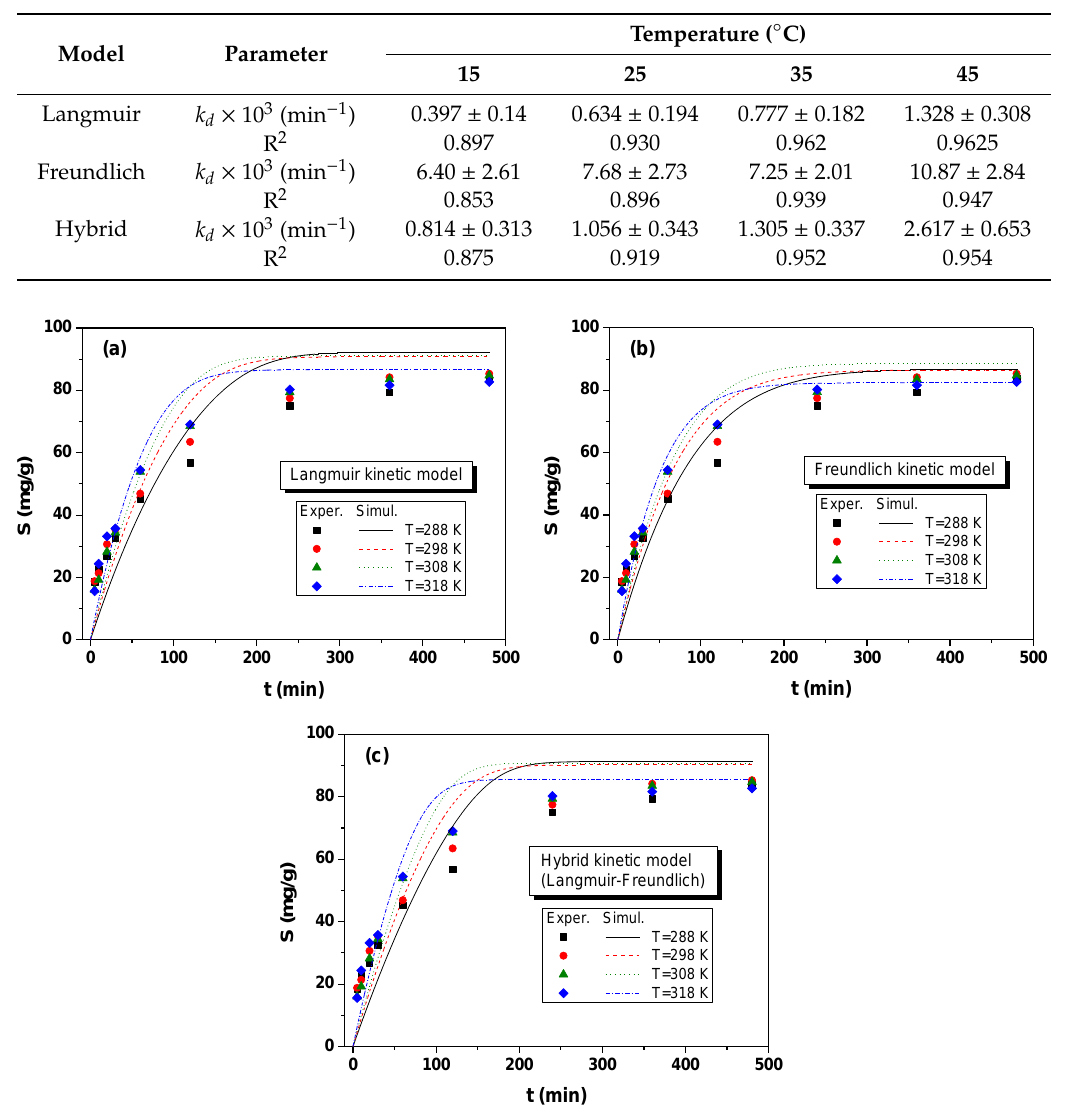
Figure 4. Experimental vs. numerically predicted transient response of MB sorption onto BP for the three kinetic models: ( a ) Langmuir; ( b ) Freundlich; ( c ) hybrid (Langmuir–Freundlich).